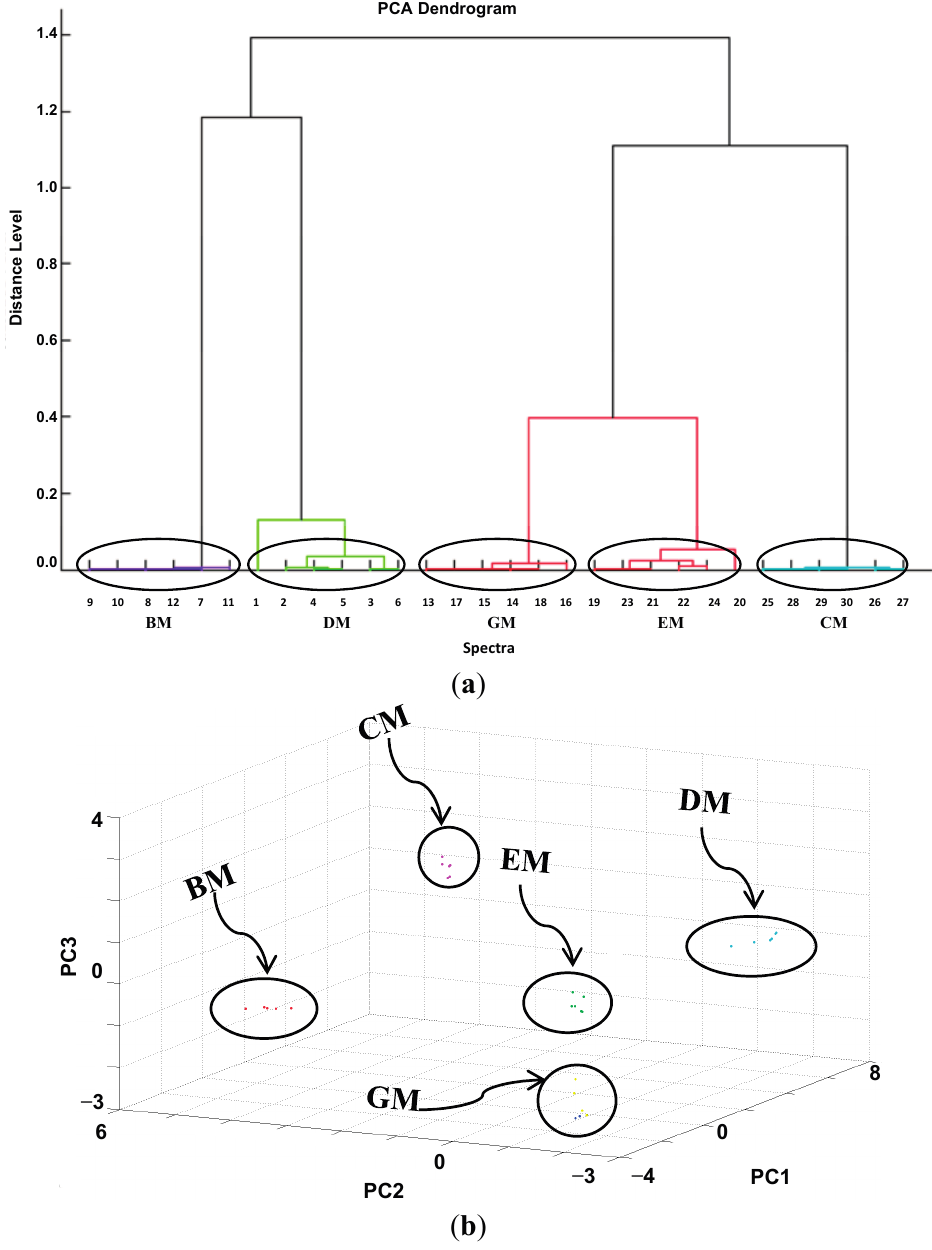
Figure 2. Data analysis of six independent matrix-assisted laser desorption/ionization time-of-flight mass spectrometry (MALDI-TOF MS) profiles of crude she-donkey’s milk (DM), goat’s milk (GM), cow’s milk (CM), ewe milk (EM) and buffalo milk (BM). ( a ) Hierarchical clustering dendrogram; ( b ) Principal component (PCA) analysis with corresponding 3D scatter plot image obtained by Biotyper; ( c ) Bootstrapped ( n = 1000) hierarchical clustering tree generated via pvclust. Values on the edges of the clustering are p -values (%). Red values are AU (Approximately Unbiased) p -values, and green values are BP (Bootstrap Probability) values as explained in methods section. Clusters with AU larger than 95% are highlighted by red boxes and indicate reliable clades; ( d ) Pearson’s correlation coefficients represented as a correlation matrix. The correlation coefficients have been colored according to a scale ranging from 0 to 1, where blue corresponds to 0 and yellow to